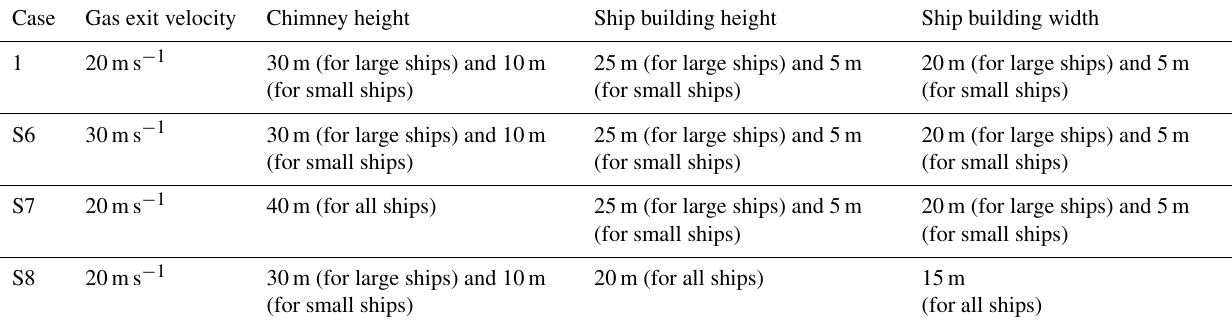
Table C1. Setups of emission sources for the MPS model in the parameter study.